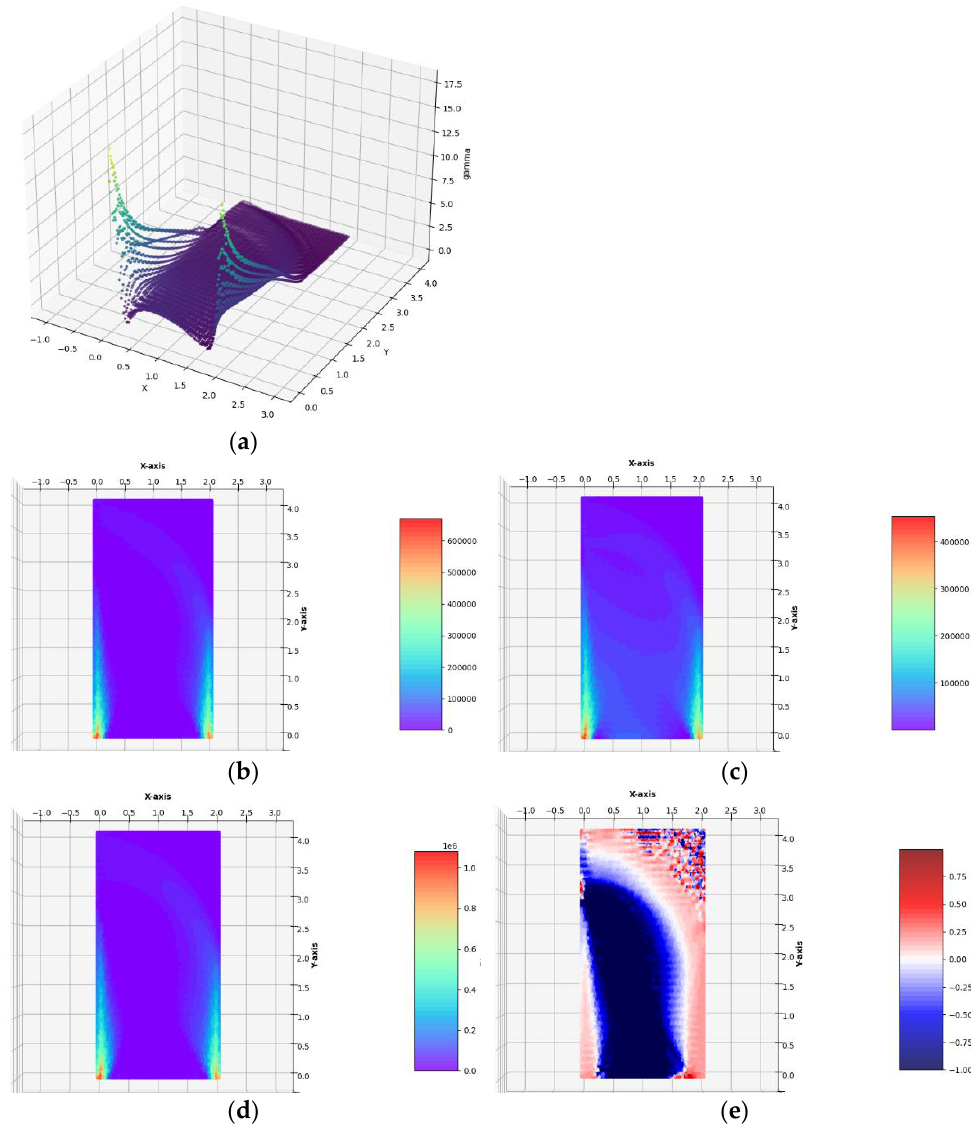
Figure 6. Optimal solutions of the problem of Example 1a. ( a ) The plot of the γ function, ( b ) bulk modulus k * / b , ( c ) shear modulus µ * / b , ( d ) Young’s modulus E * / b , ( e ) Poisson’s ratio ν * in the case of FEM mesh composed of quadrilateral elements.